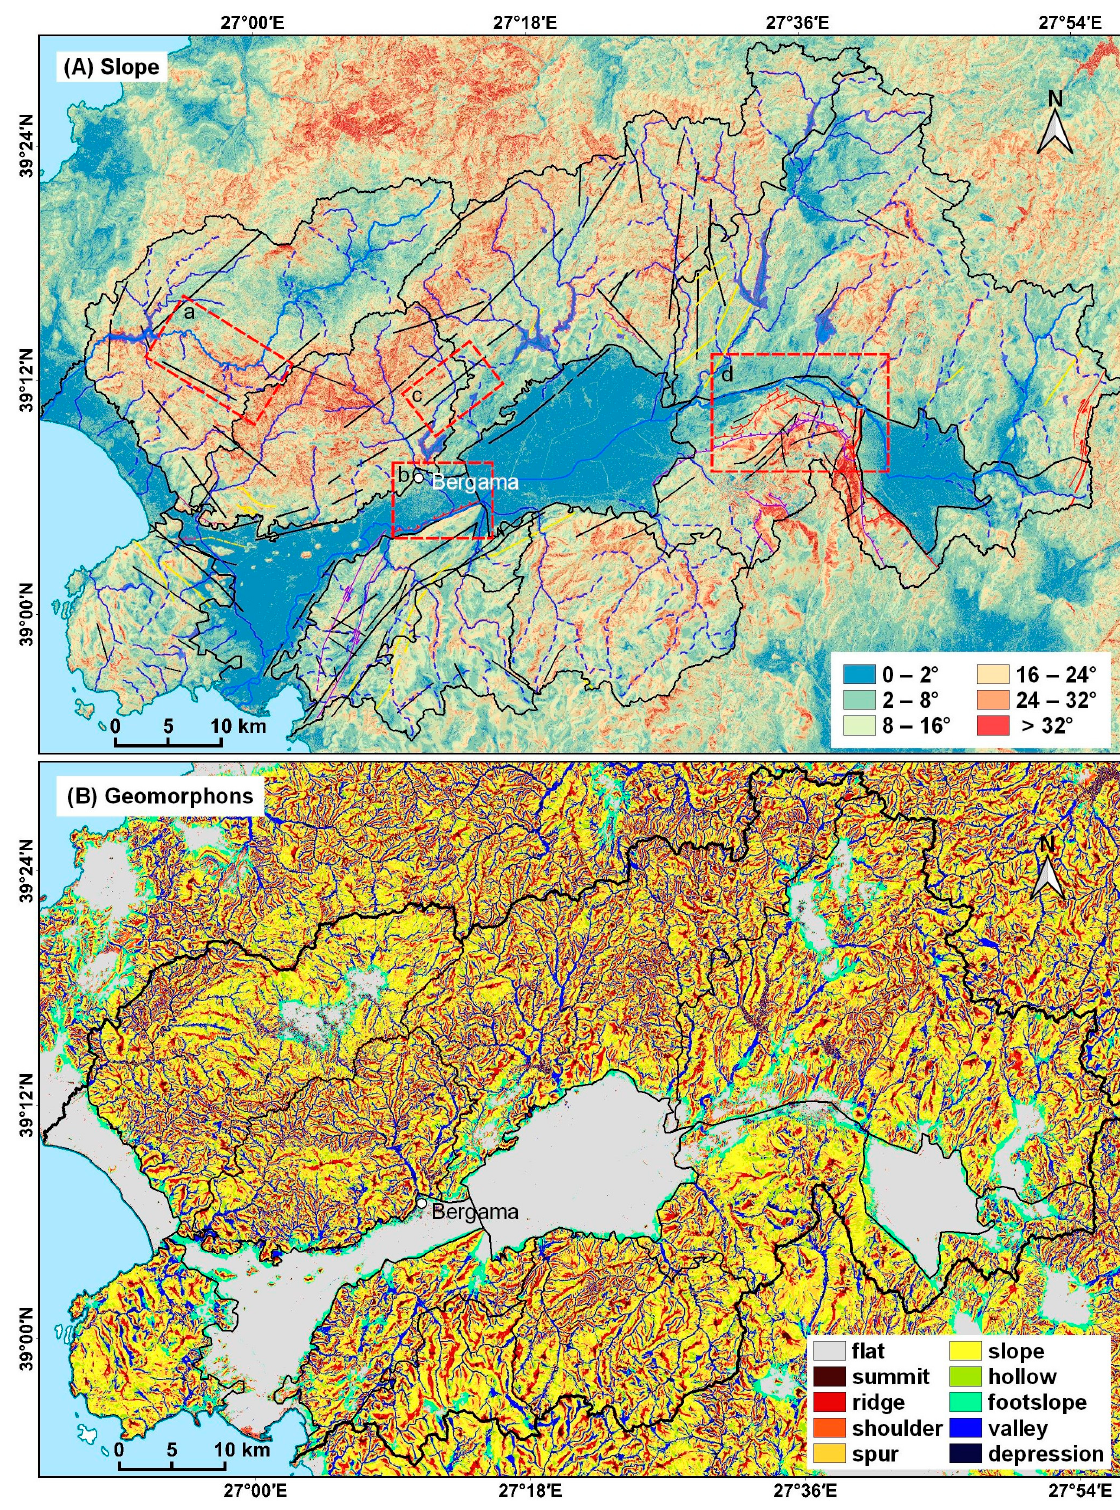
Figure 5. Morphometric characters of the Bakırçay and Madra River catchments. ( A ) Slope with perennial streams (streams were based on [69–72]) and faults (for fault legends see Figure 2; the red dashed rectangles numbered with a, b, c and d denote the geomorphological features under the impacts of tectonics, see the Discussion section). ( B ) Geomorphons. See Figure 1C for the geomorphological